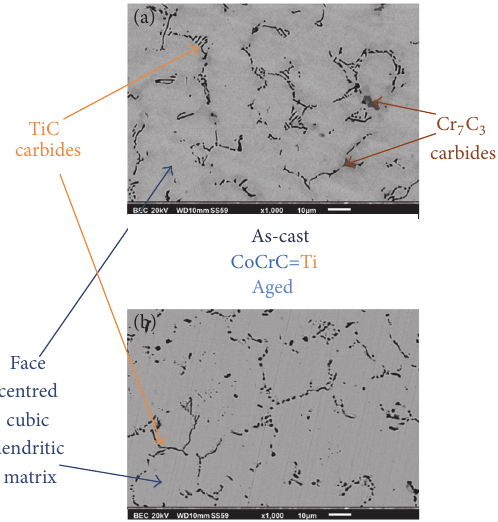
Figure 3: The as-cast (a) and aged (b) microstructure of the “CoCrC=Ti” alloy (SEM/BSE micrographs).